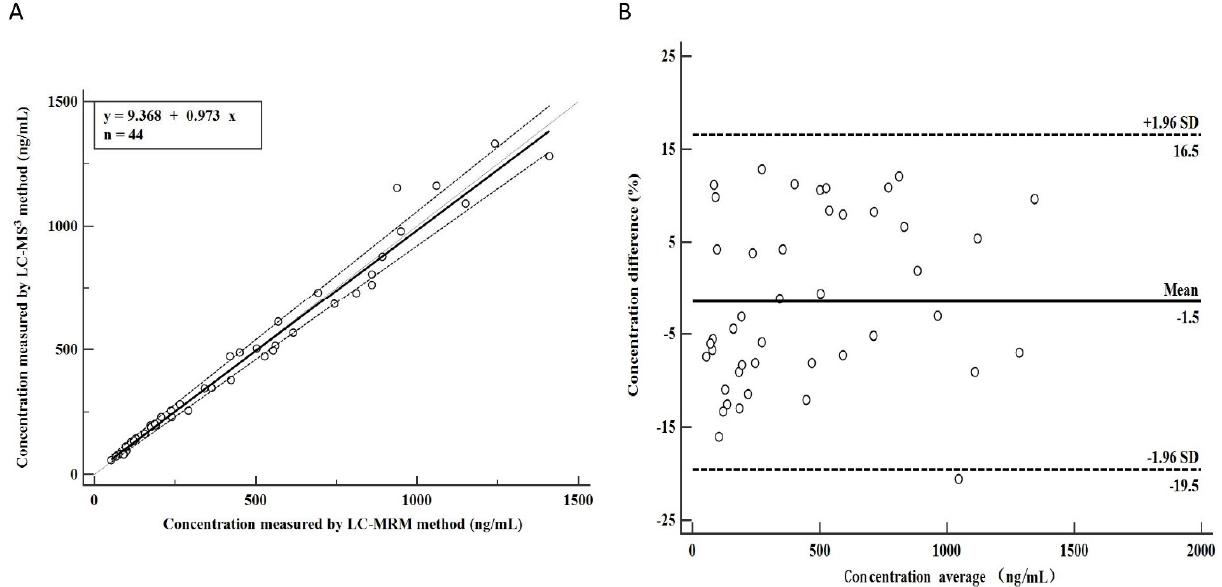
Figure 5. Comparison of the LC-MRM and LC-MS 3 methods. ( A ) Passing-Bablok correlation plots of the concentration of AMT from clinical patients. The solid black lines indicate the Passing-Bablok regression. ( B ) Bland-Altman analysis verifies the difference in AMT concentration measured using the LC-MRM and the LC-MS 3 in 44 human plasma samples.